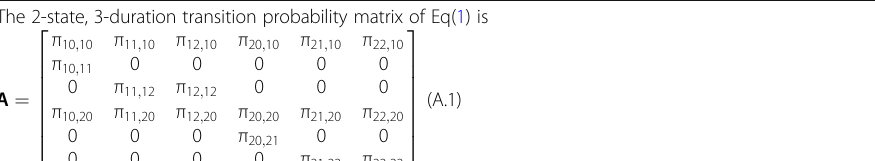
Table 1 Elements of the 2-state, 3-duration transition probability matrix